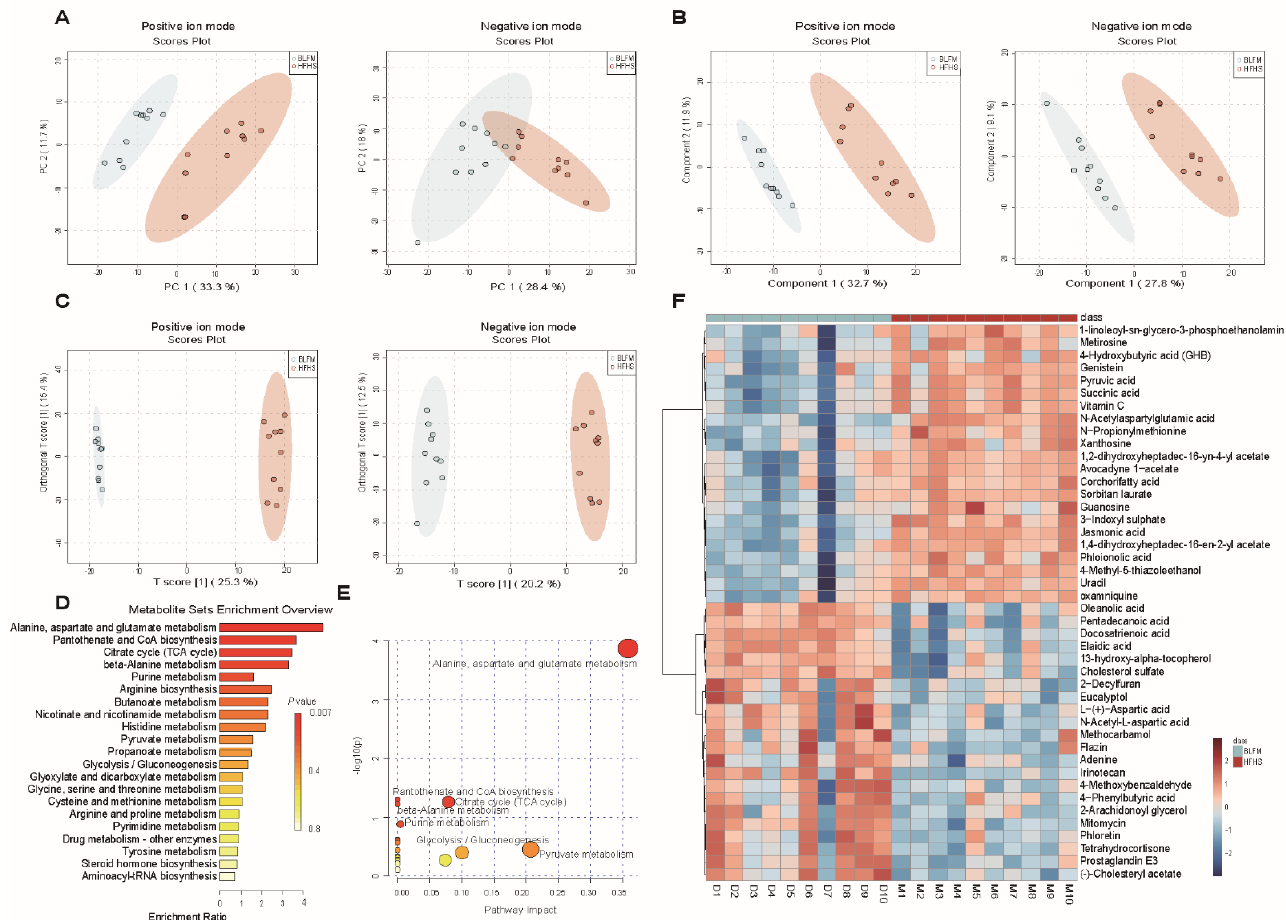
Figure 5. Supplementation of fermented milk changes the fecal metabolites and related KEGG pathways of mice on HFHS diet: ( A ) principal component analysis (PCA), ( B ) Partial Least Squares Discriminant Analysis (PLS-DA), ( C ) Orthogonal Partial Least Squares Discriminant Analysis (OPLS-DA), ( D ) KEGG pathway enrichment histogram, ( E ) Overview of pathway analysis, ( F ) heatmap of differential metabolites.